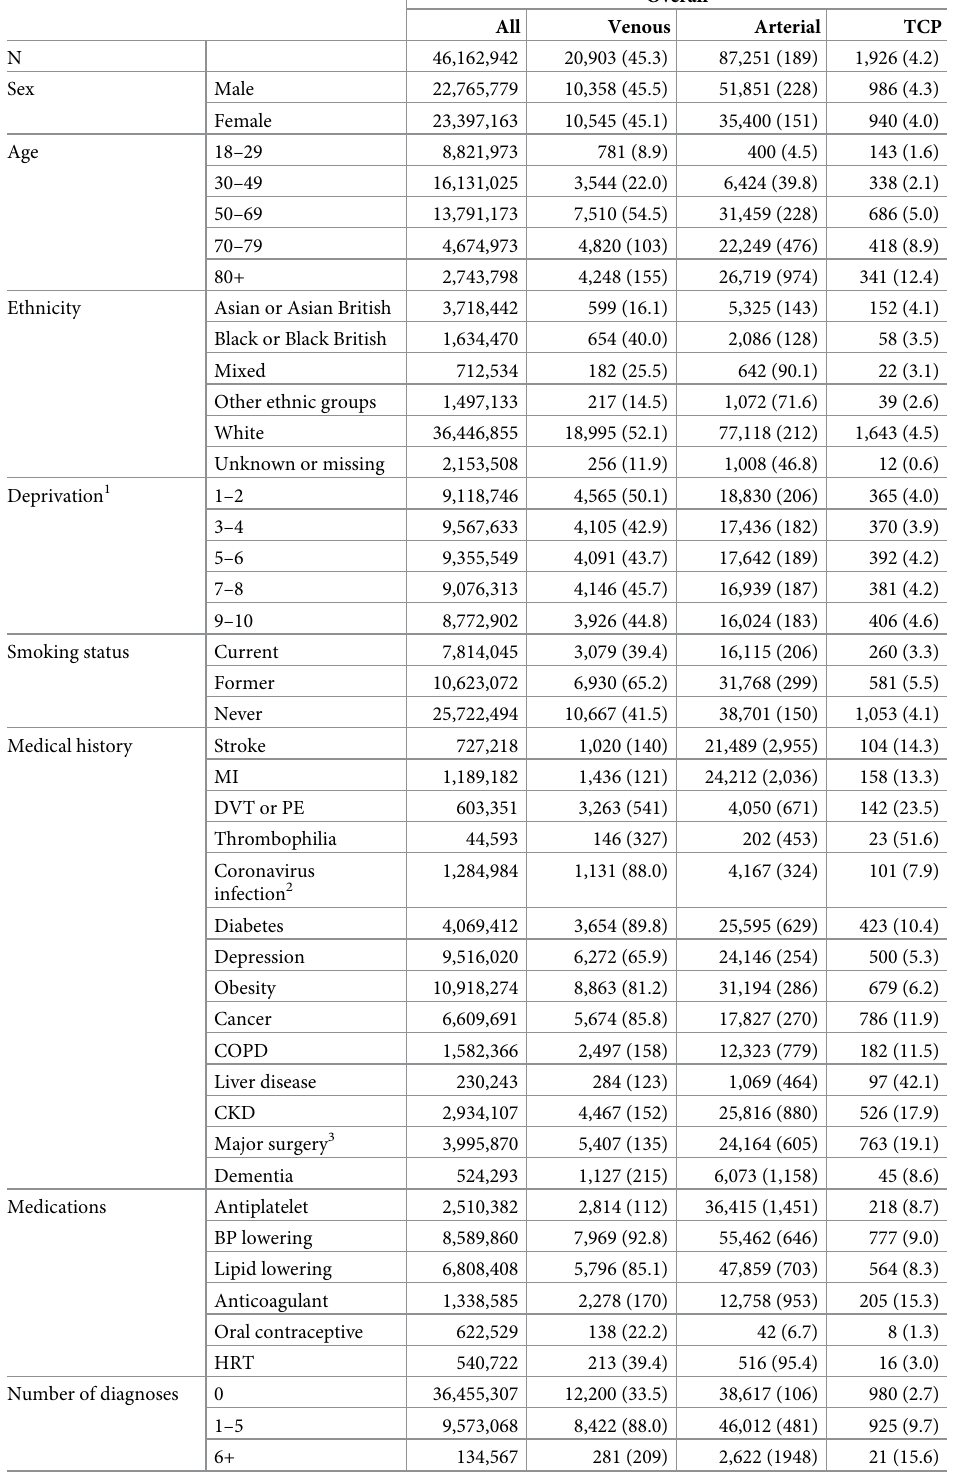
Table 1. Numbers of patients analysed and (in parentheses) risk per 100,000 people for the whole population dur- ing follow-up of venous and arterial events and TCP.